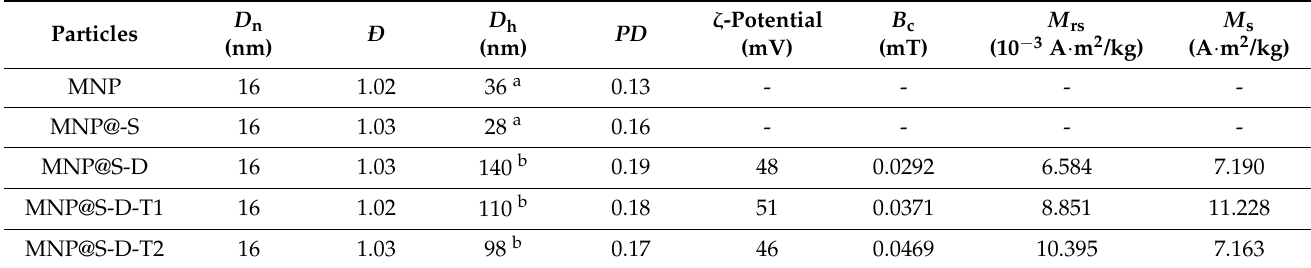
Table 1. Physicochemical characterization of the iron oxide